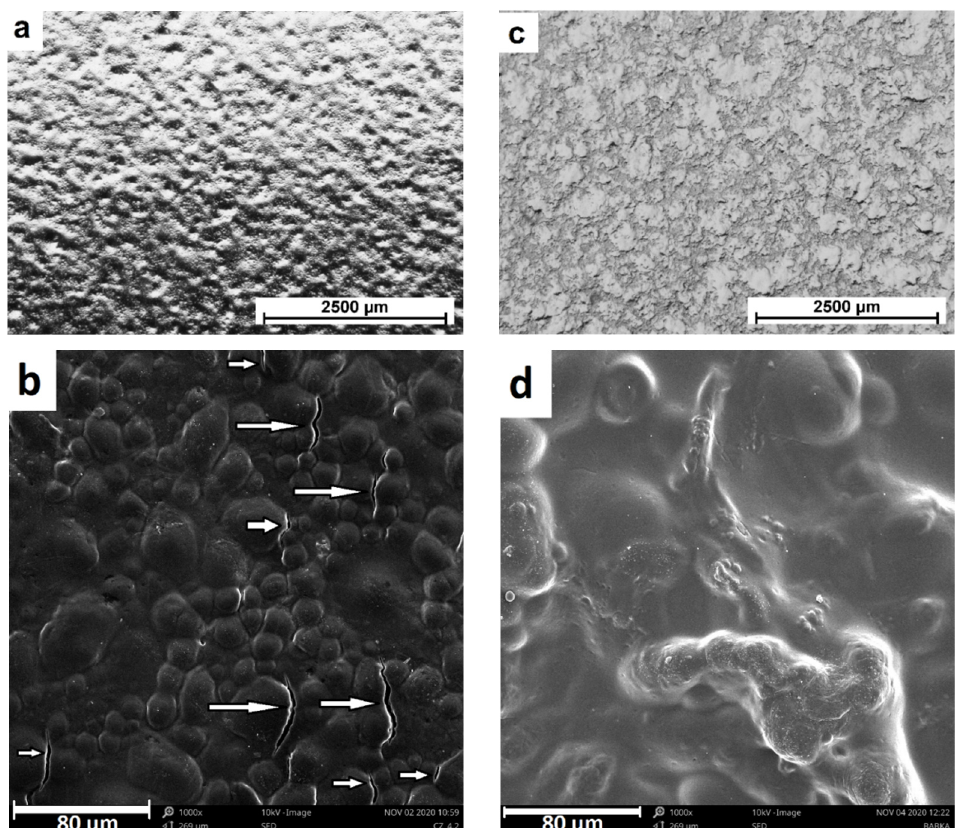
Figure 2. SEM images of the surfaces of TPS/P ( a , b ) and TPS/PH ( c , d ) films.